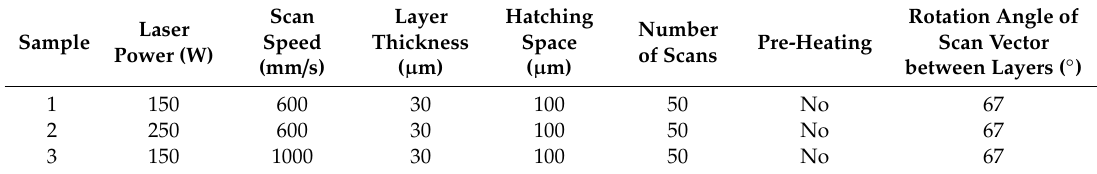
Table 2. Process parameters designed for the fabrication of IN718 specimens using L-PBF.